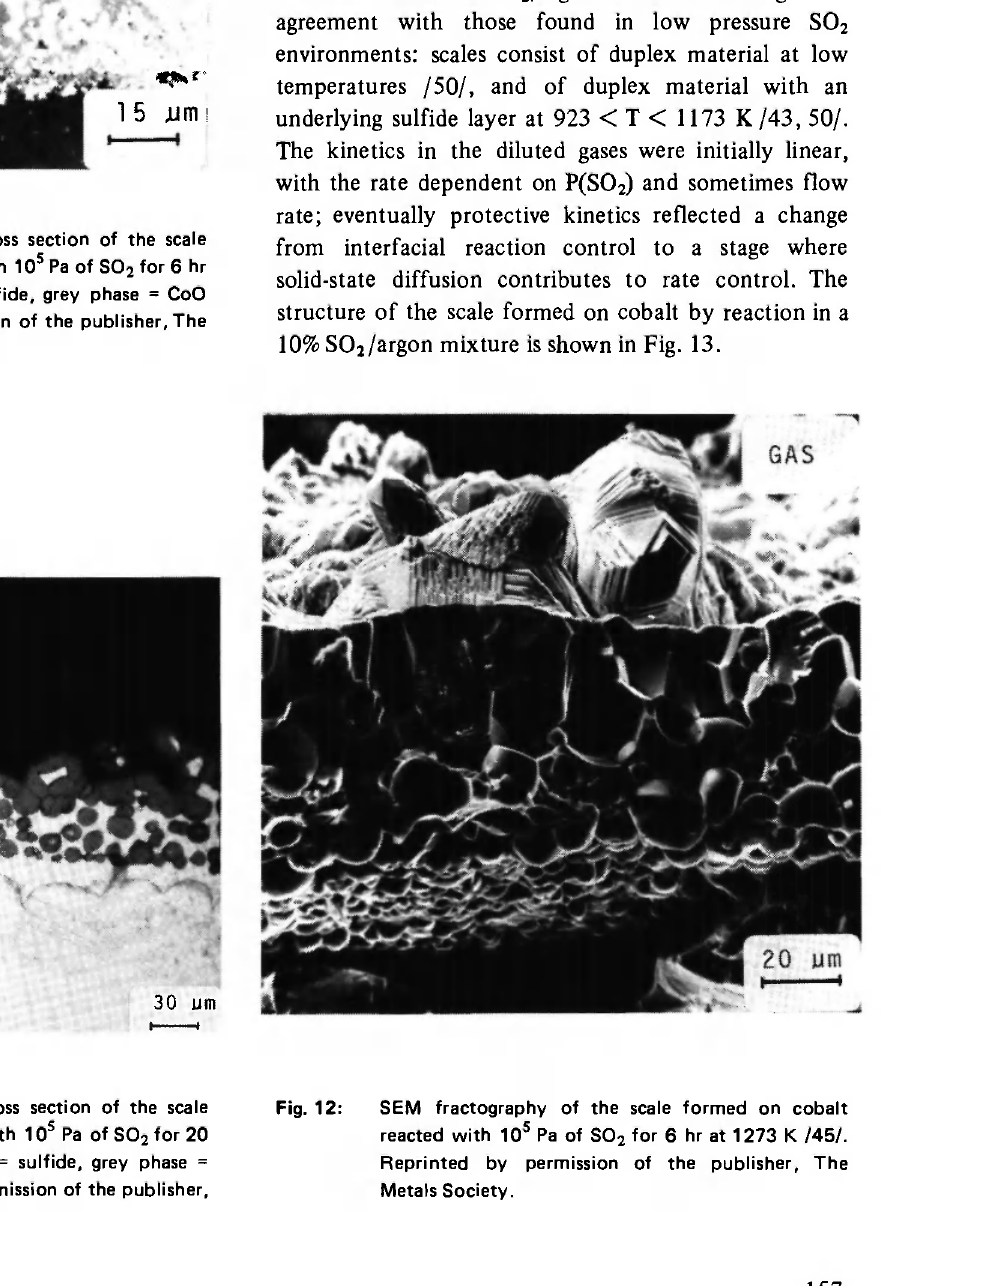
Fig. 10: Optical micrograph of a cross section of the scale formed on cobalt reacted with 10 s Pa of S0 2 for 6 hr at 973 K: light phase = sulfide, grey phase = CoO /45/. Reprinted by permission of the publisher, The Metals Society.